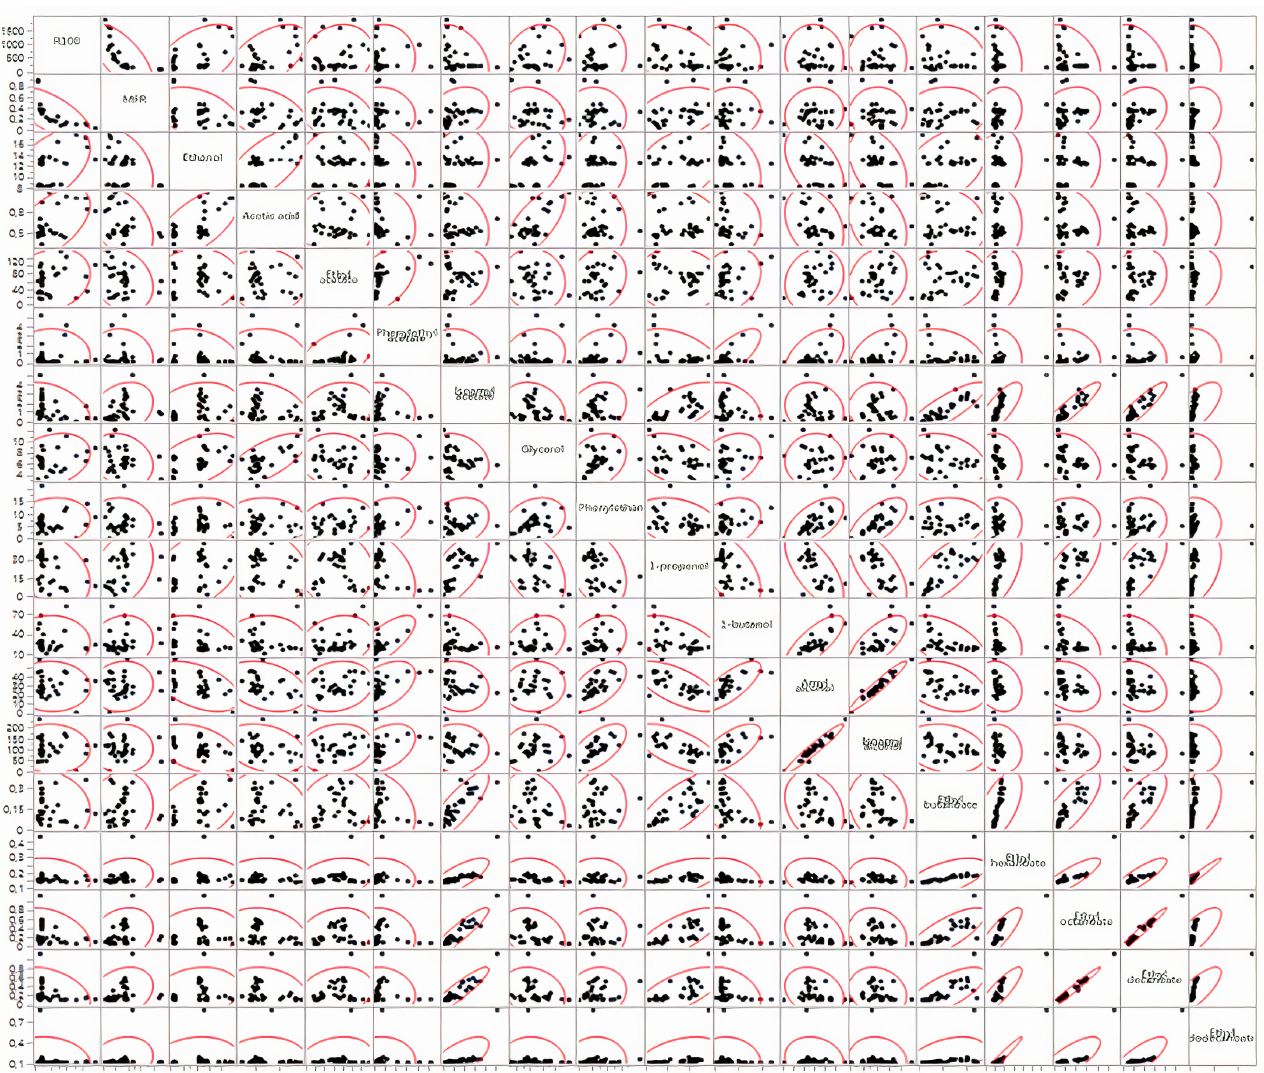
Figure 2. Matrix scatterplot for the 18 responses.